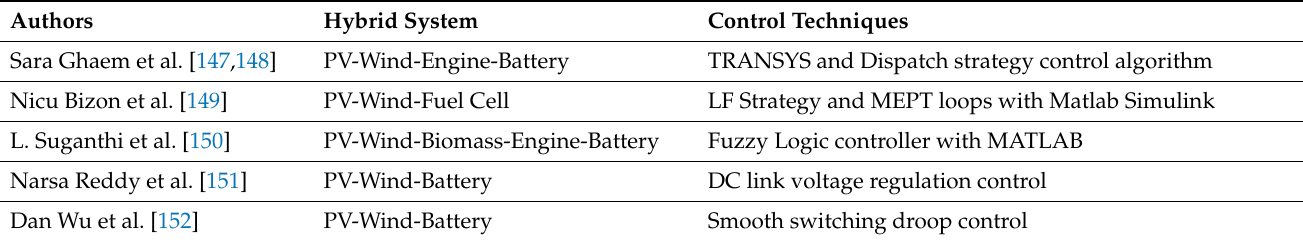
Table 7. Control strategy for PV-wind IHMS